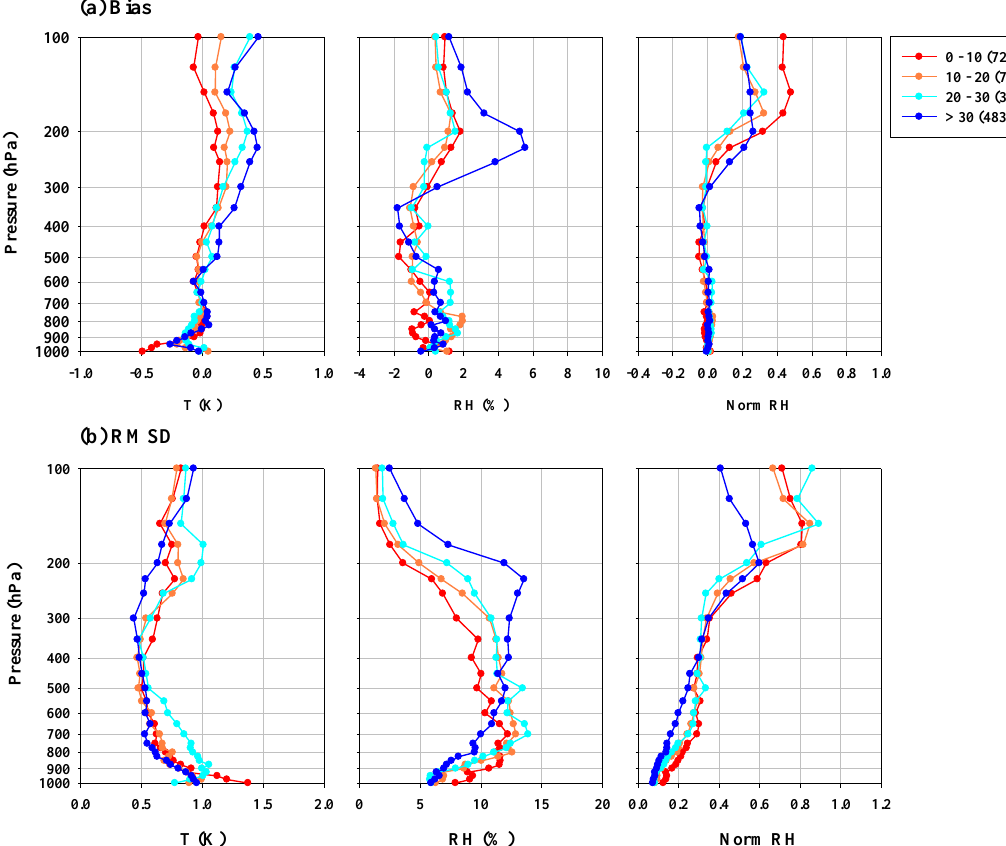
Figure 7. Error statistics of the United Kingdom Met Office model (UM-UKMO) temperature and relative humidity profiles classified according to the total precipitable water between the surface and 100 hPa (TPW, in kg·m −2 ). ( a ) Bias and ( b ) RMSD.